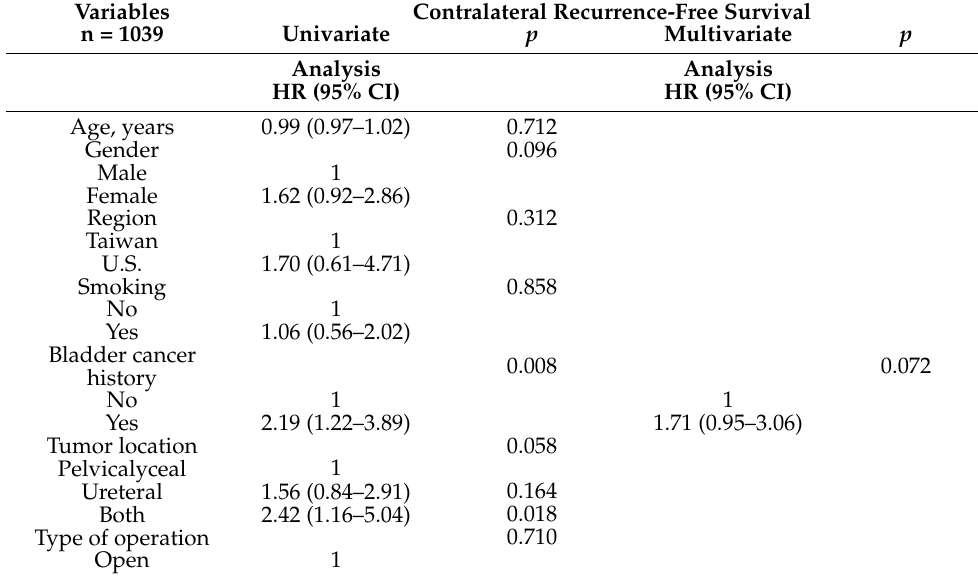
Figure 2. In Kaplan–Meier analysis, bladder cancer history, tumor number, and CKD stage of patients with upper tract urothelial carcinoma (UTUC) from Taiwan ( A , C , E ) or the U.S. ( B , D , F ) were significantly associated with contralateral recurrence. Table 3. Univariate and multivariate analyses predicting contralateral recurrence in the 1039 patients with UTUC after